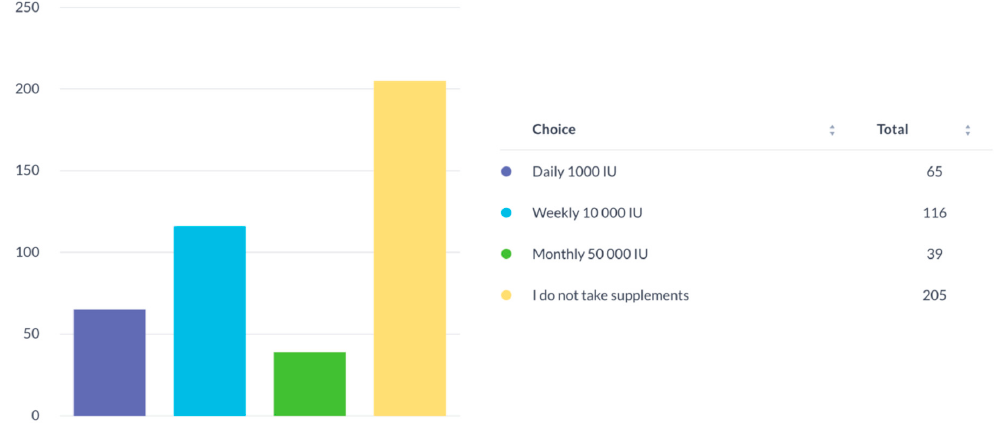
Figure 1. Vitamin D supplement use by participants. The descriptive statistics for the study’s continuous variables are detailed in Table 2. Notably, the mean GAD-7 and SAI scores were 12 (SD = 6) and 17 (SD = 5), respectively, suggesting relatively high levels of anxiety and avoidance of sun across the whole popu- lation. On the other hand, the mean FFQ score of 10 (SD = 8) revealed an inadequate die- tary intake of vitamin D-rich foods (Table 2). Table 2. Descriptive statistics for key variables for study participants.